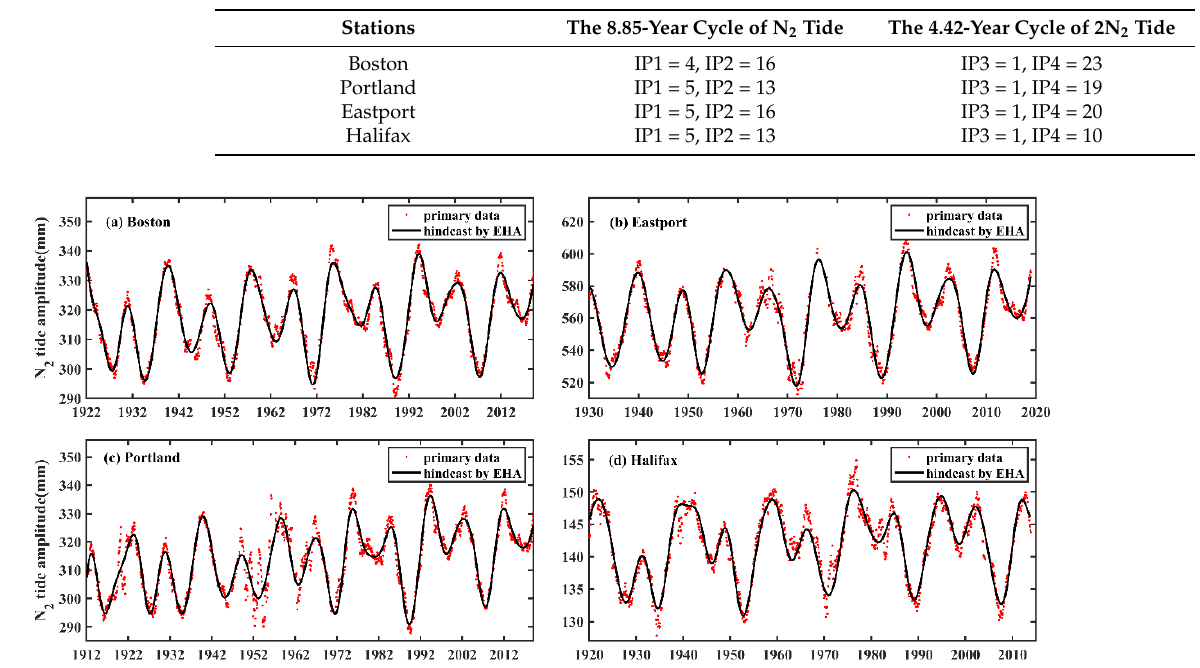
Figure 2. The primary amplitudes (red dots) and the hindcasts amplitudes by the EHA method (black lines) of N 2 tide at 4 stations with the best-fit numbers of IPs for the 8.85-year cycle (listed in Table 6).